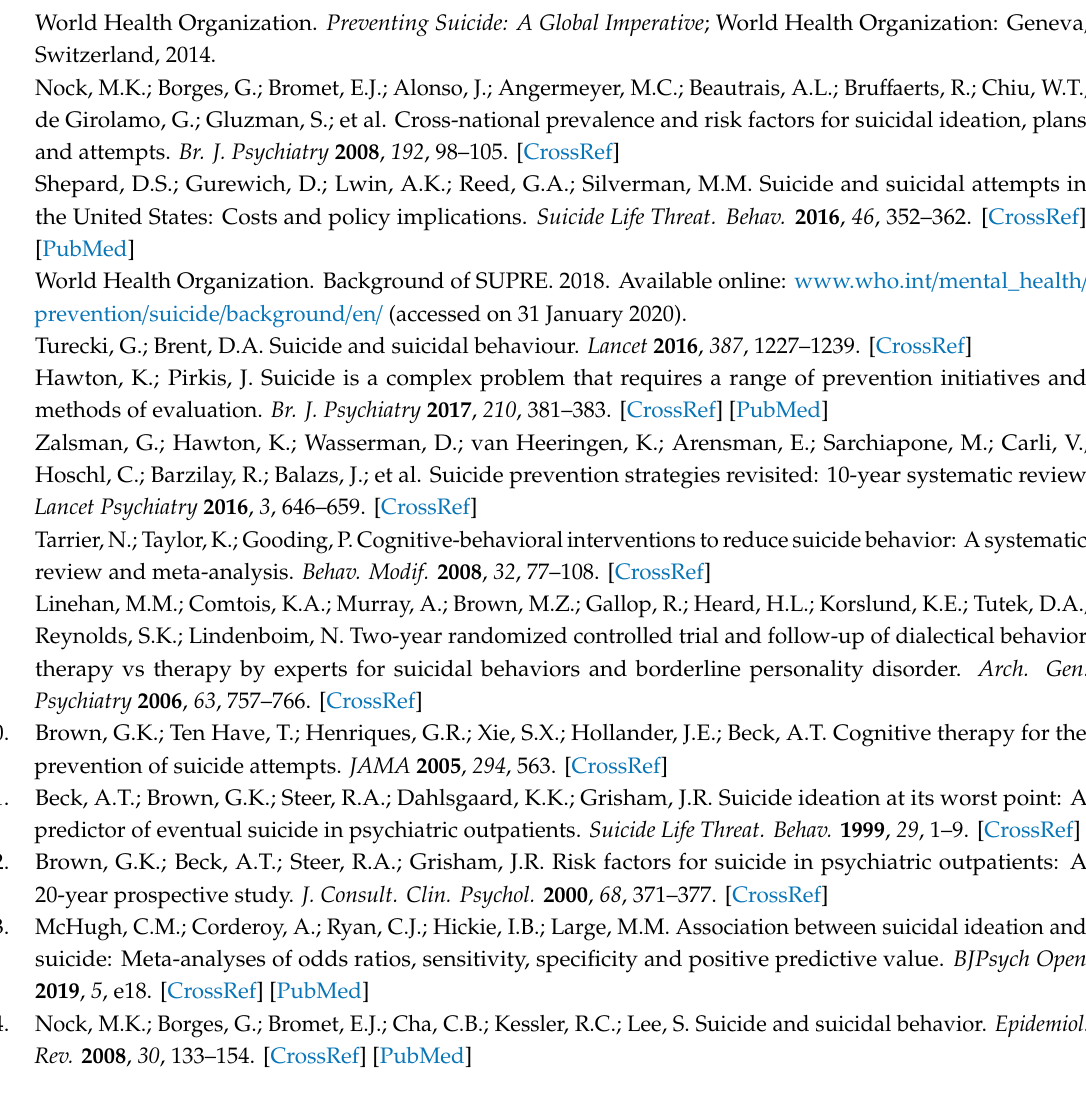
Table S1: Search strings for CENTRAL, PsycINFO, Embase and